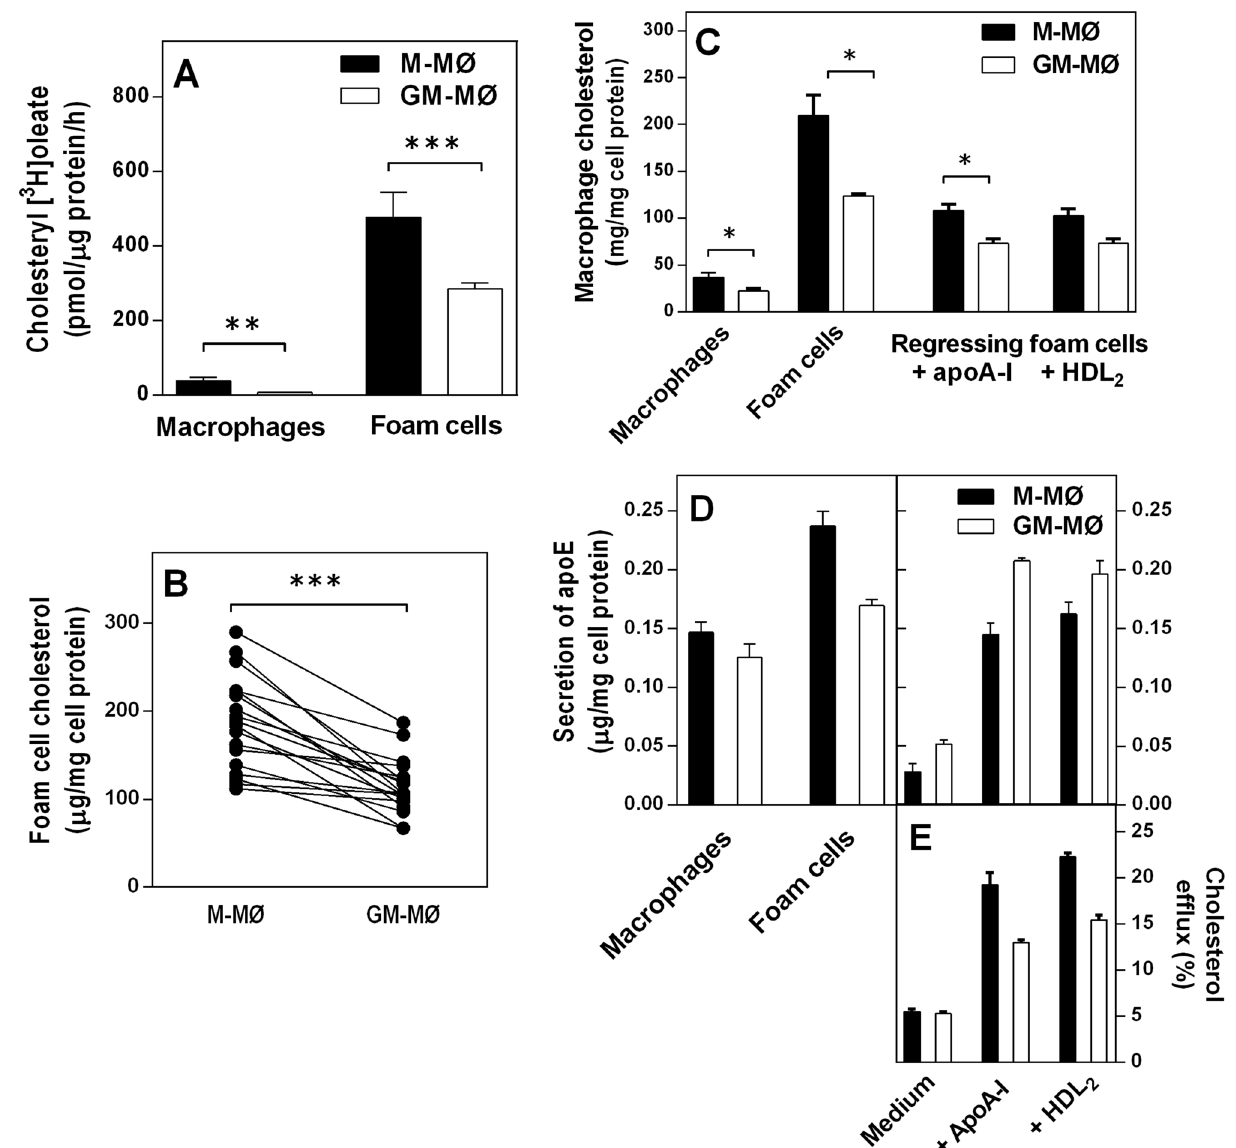
Figure 6. Cholesterol esterification activity, apoE secretion, and cholesterol efflux in M-MØ and GM-MØ foam cells. ( A ) ACAT1-mediated esterification activity was measured as the rate of [ 3 H]oleate incorporation into cholesteryl esters in M-MØ and GM-MØ which were incubated in the absence (Macrophages) or presence (Foam cells) of acetyl-LDL, after which the cells were incubated with [ 3 H]oleic acid-BSA complexes. Cellular lipids were extracted and [ 3 H]-activity was determined. ( B ) Cholesterol contents in the foam cells of each CSF subtype. ( C ) Cholesterol contents in M-MØ and GM-MØ before (Macrophages) and after incubation with acetyl-LDL (Foam cells), and after cholesterol efflux to apoA-I (10 µg/mL) and HDL 2 (25 µg/mL) (Regressing foam cells). ( D ) Macrophages were loaded with cholesterol and cholesterol efflux was induced by adding apoA-I or HDL 2 to the incubation medium, and the concentrations of apoE in the media were determined by ELISA. ( E ) Cholesterol efflux from [ 3 H]CE-labeled macrophage foam cells of either subtype was evaluated by measuring the macrophage-derived [ 3 H]-radioactivity in media when the cells were incubated with medium alone, apoA-I or HDL 2 . Fractional efflux was calculated as [dpm medium/(dpm cells + dpm medium)] × 100. Data are presented as means ± SEM of 9 ( A ); 17 ( B ); 2 ( C ); 6 ( D ); and 6 ( E ) individual blood donors and triplicate incubations for each studied condition. **p < 0.01 and ***p < 0.001 by Student’s t-test for paired samples ( A , B ); *p < 0.05 by Wilcoxon Signed-Rank test for paired samples (triplicate wells per assay) ( C ); *p < 0.05 by Student’s t-test for paired samples ( D ); *p < 0.05 by Student’s t-test for paired samples ( E